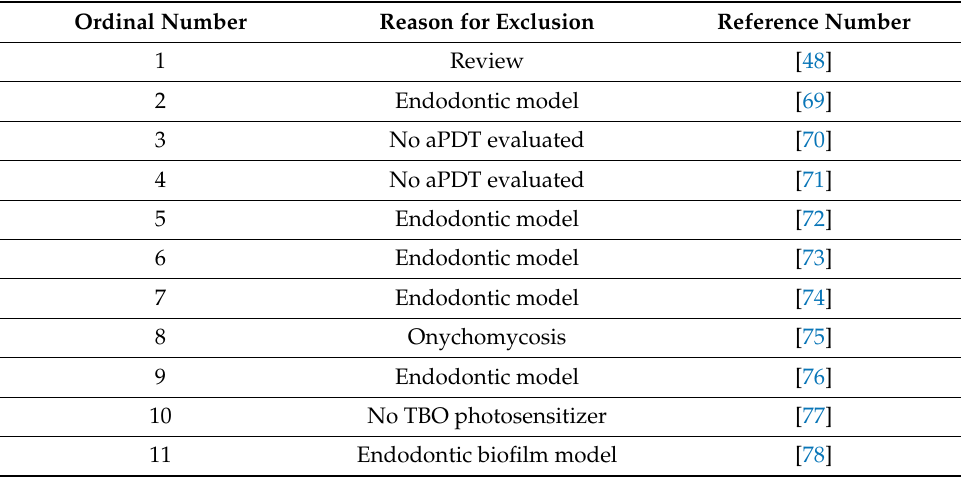
Table 1. Excluded studies and the reasons for their